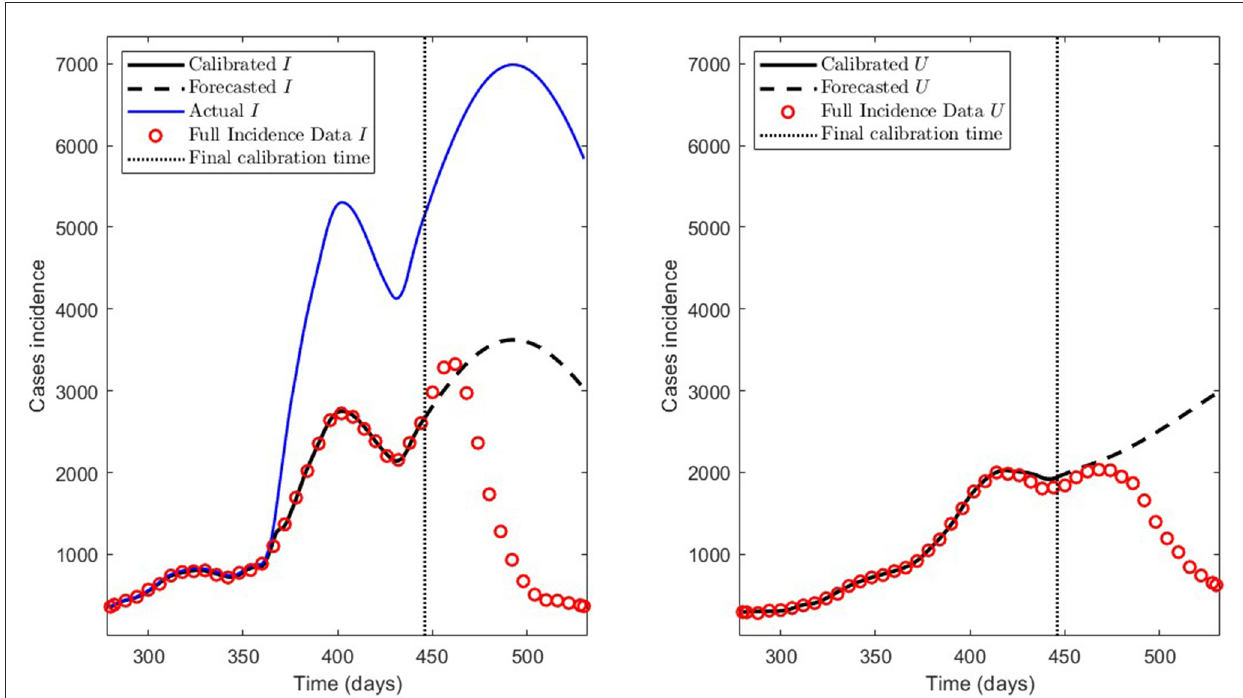
FIGURE10 Incidence curves obtained by least-squares. 7 December 2020 to 14 August 2021, encompassing the Metropolitan region’s second wave in Chile.